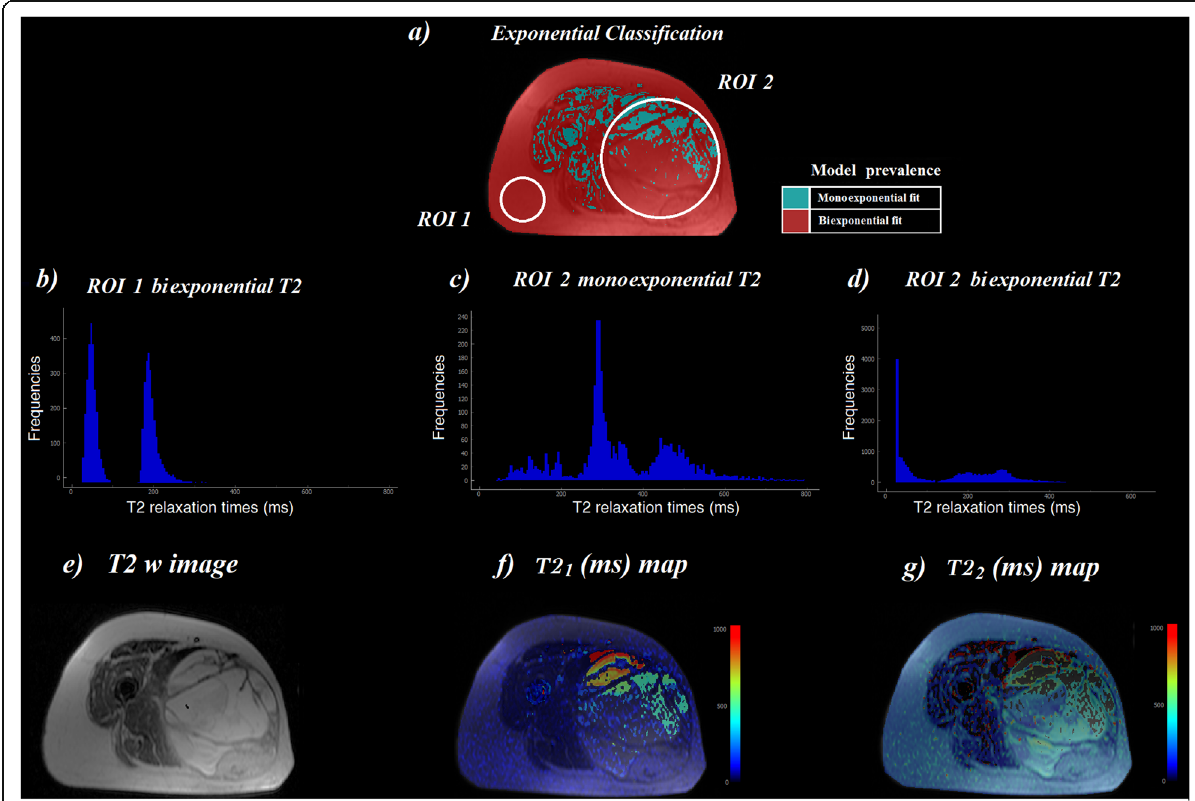
Fig. 2 a Whole slice Mexp analysis for a lower limb sarcoma where ROI_1 is indicative for healthy adipose tissue area and ROI_2 corresponds to a malignant region. b – d Mexp-derived spectra for ROI_1 and ROI_2. e T2-weighted images. f , g Whole slice T2 i parametric